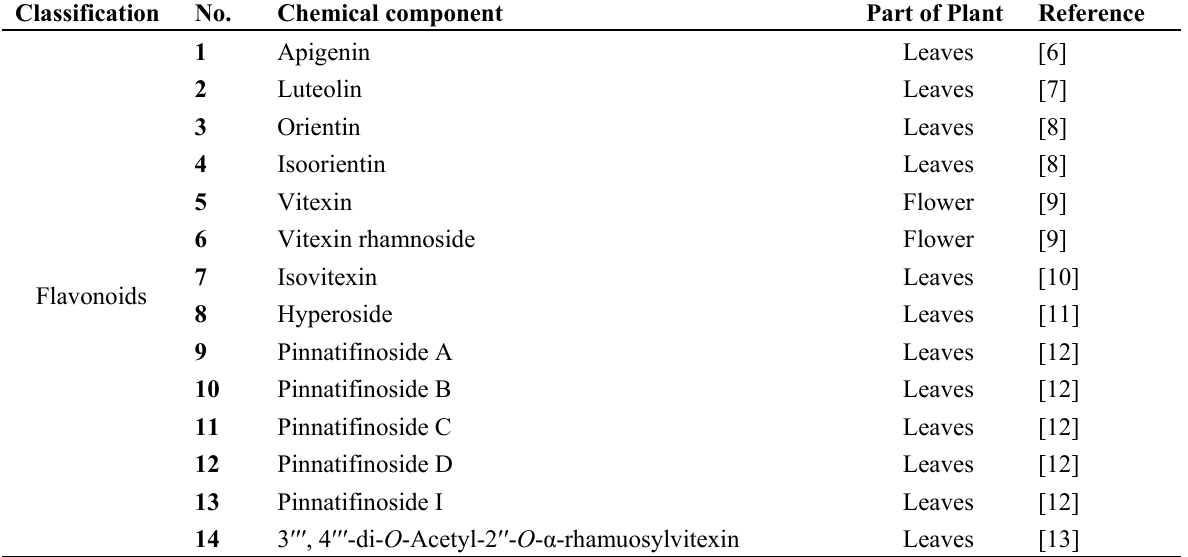
Table 1. Chemical compounds isolated from Chinese